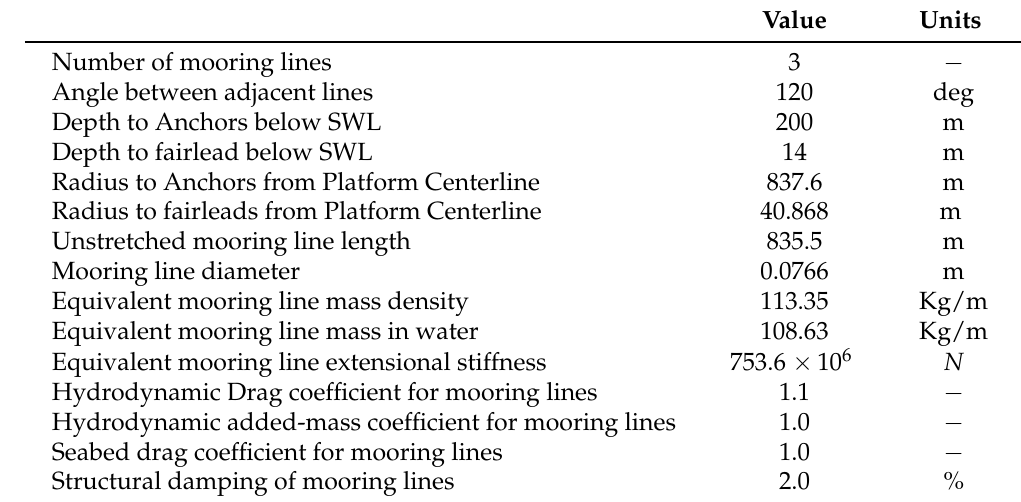
Table 2. OC4-DeepCWind mooring system properties [33].